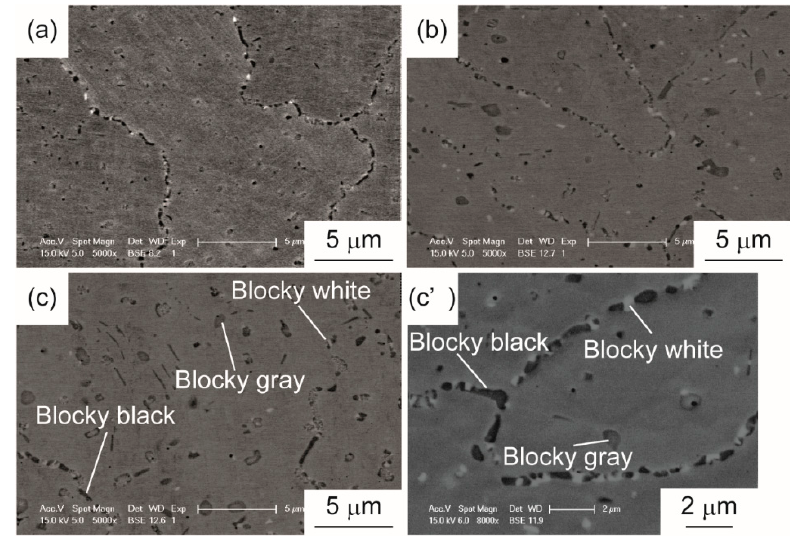
Figure 4. Scanning electron microscopy-backscattered electron imaging (SEM-BSE) images of the ( a ) top part, ( b ) center part, and ( c , c’ ) bottom part of the high-C as-built alloy; ( c’ ) is a magnified image of ( c ).